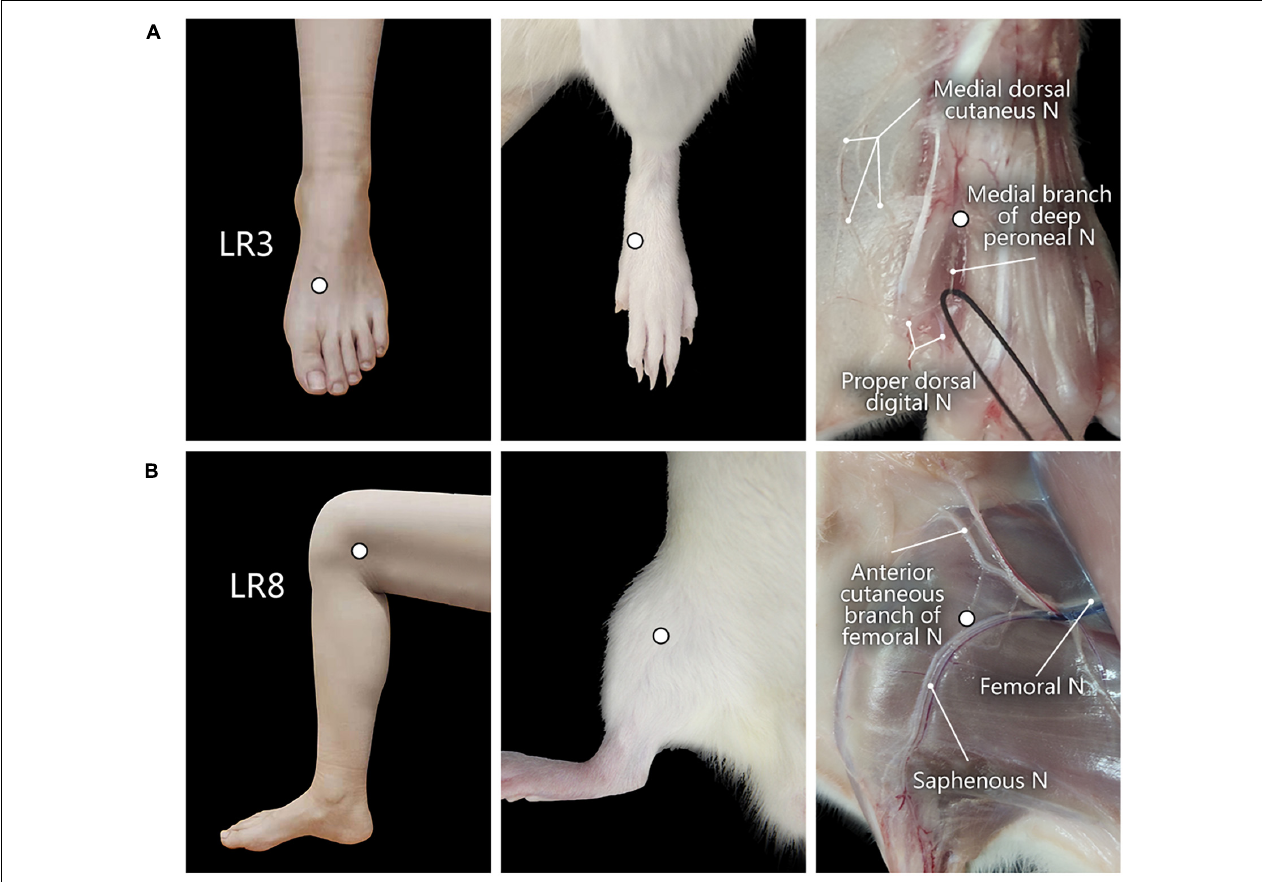
FIGURE 1 | Location of acupoints “Taichong” (LR3) and “Ququan” (LR8) and their regional anatomy. (A,B) The sites of LR3 (A) and LR8 (B) in humans and rats, as well as their regional views of nerves (N) in